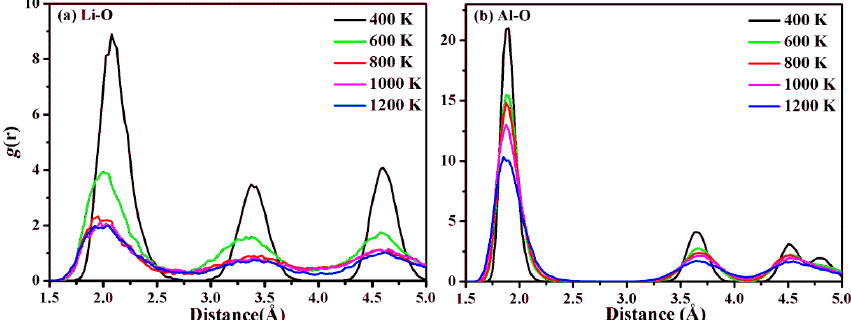
Figure 3. Pair distribution functions for ( a ) Li–O and ( b ) Al–O distances in LiAl 2 (OH) 6 Cl at various simulated temperatures